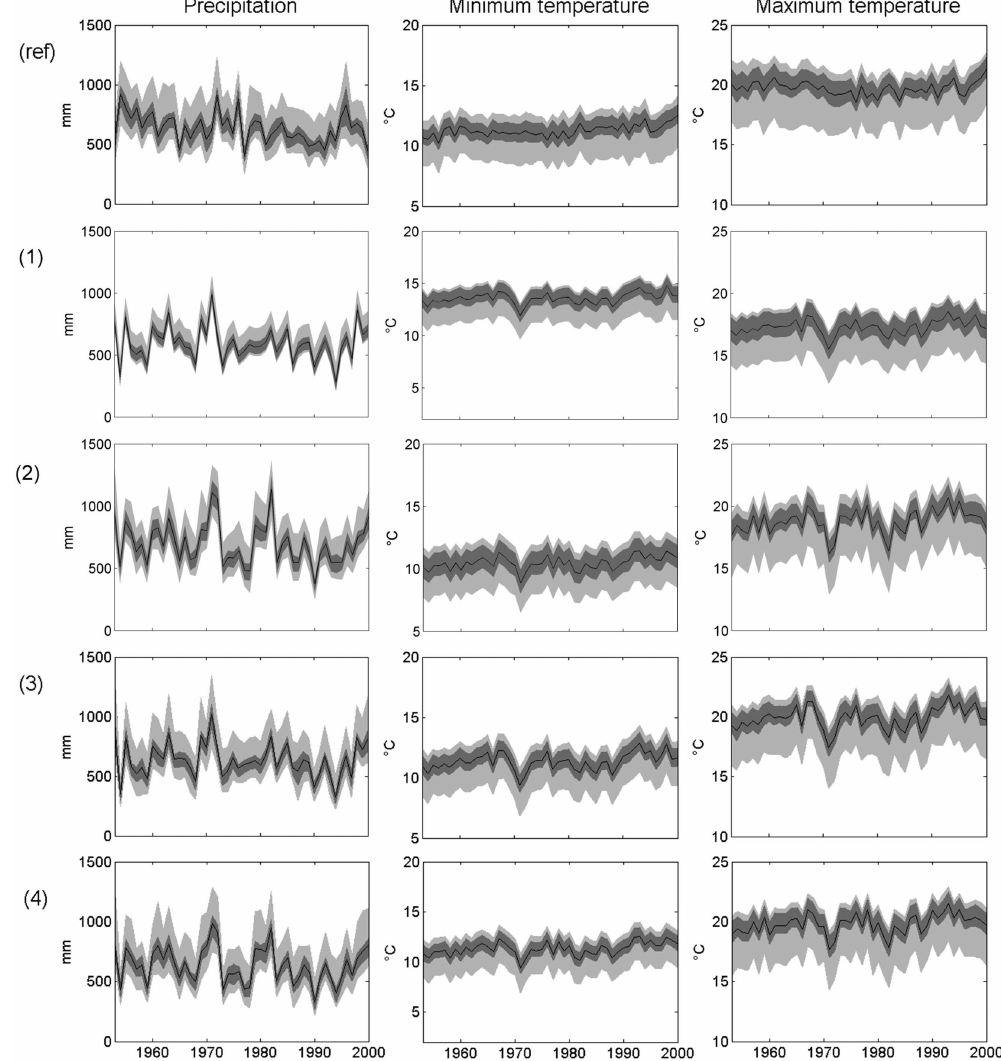
Fig. 4. Spatial average of annual precipitation, minimum and maximum temperature (black line) and associated quantiles (25th and 75th, 5th and 95th plotted as dark and light grey areas, respectively) for land observations (ref), GCM (1), GCM-DD (2), GCM-SD (3) and GCM-DD-SD (4) (see Fig.